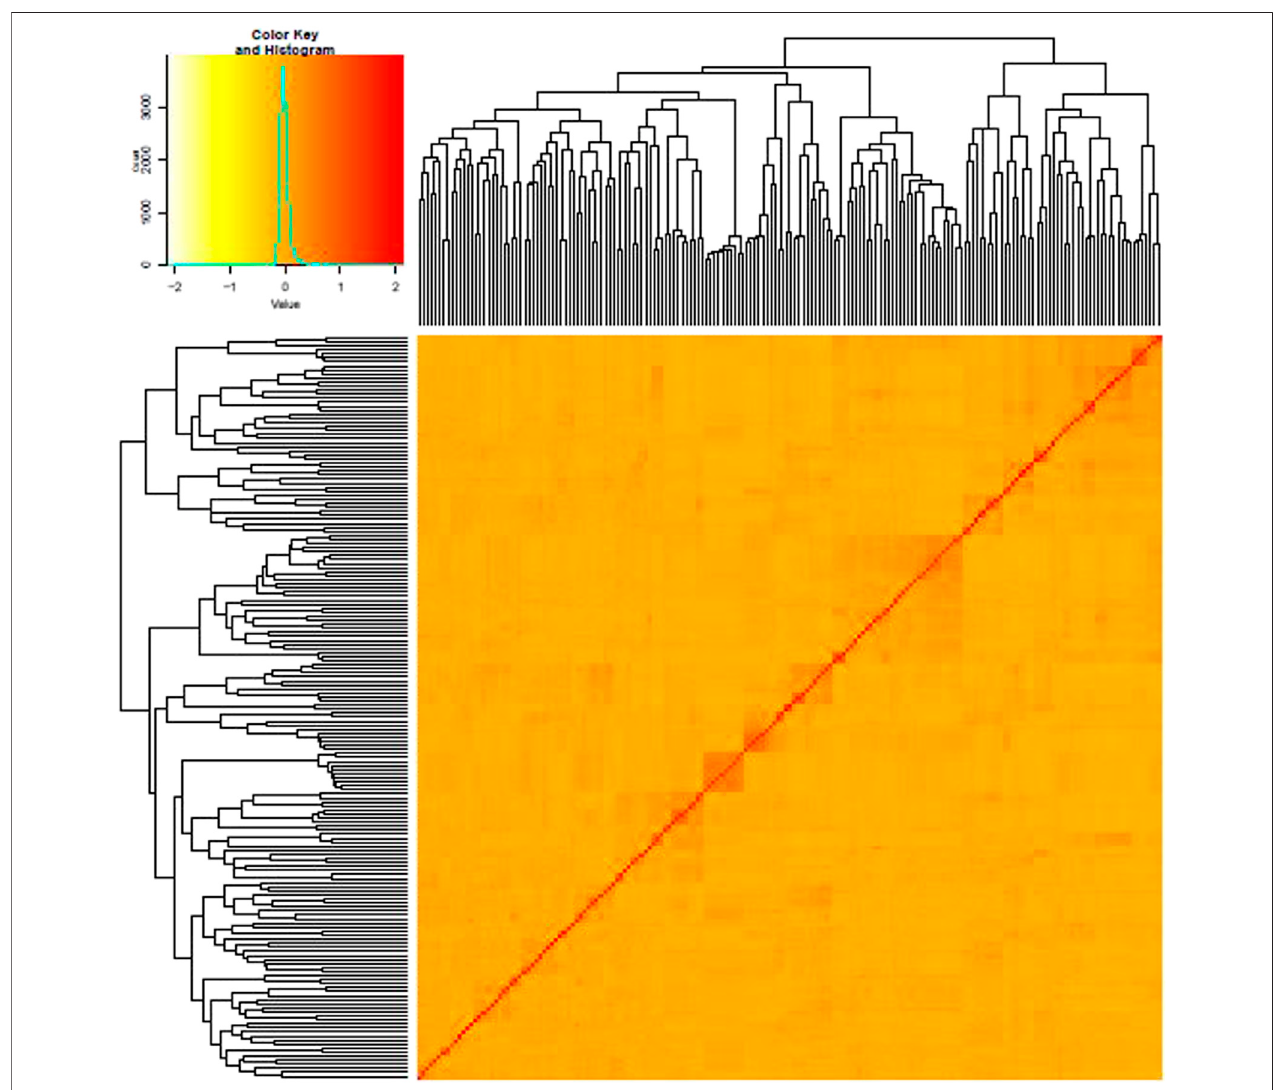
FIGURE 4 | Heat map of kinship matrix with the dendrogram shown on the top-left side based on 123,596 markers.